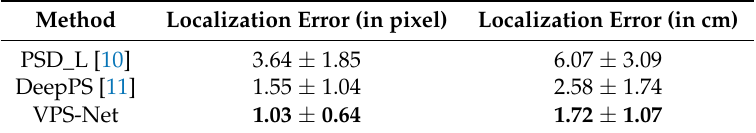
Table 6. Localization error of parking slots of different methods in the ps2.0 test